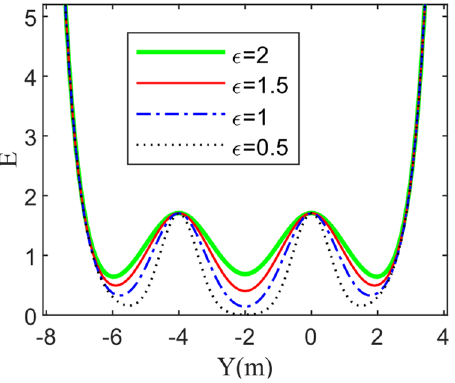
Figure 6. Different coefficients of convergence of the traffic line mark’s risk fields on the HV.